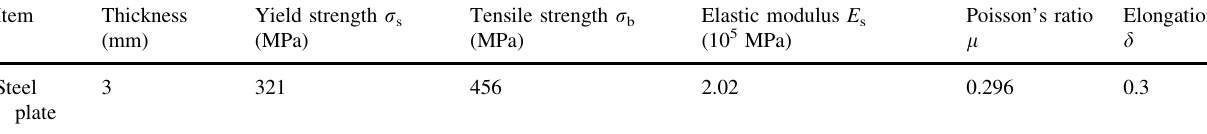
Table 4 Mechanical properties of steel